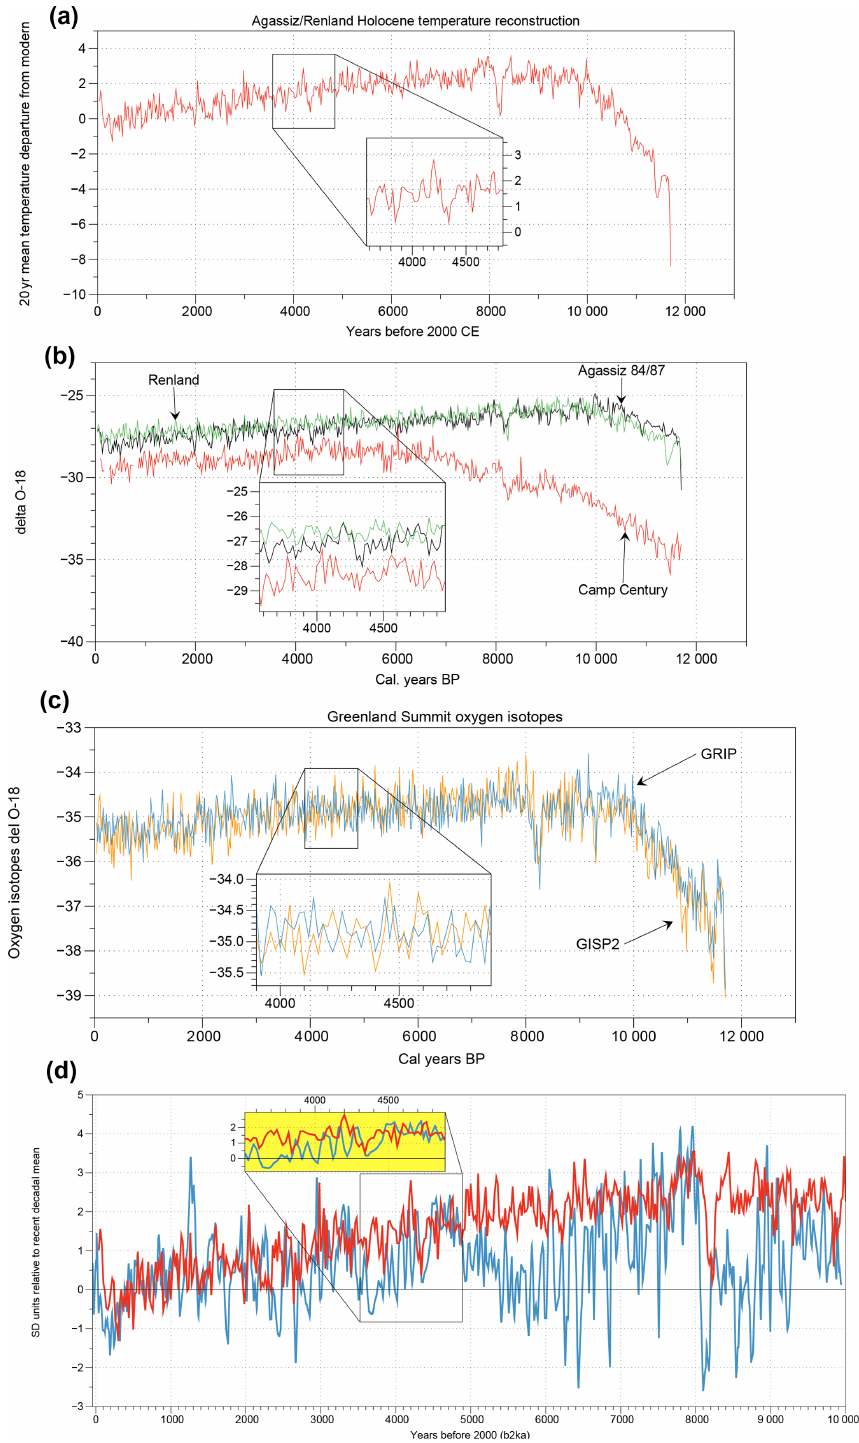
Figure 3. (a) Temperature anomalies from the smoothed estimate of present temperatures in Greenland based on oxygen isotope records from Renland Ice Cap (East Greenland) and Agassiz Ice Cap (Ellesmere Island). Timescale is in years b2k (before 2000CE). The interval around 4.2kaBP is enlarged in the box (data source: Vinther et al., 2009). For locations, see Fig. 5. (b) Individual oxygen isotopic records from Renland and Agassiz ice caps (which were combined to create the record in Fig. 3a) and from Camp Century. (c) Individual oxygen isotopic records from GRIP and GISP2 at Summit, Greenland Ice Sheet. (d) Paleotemperature estimates from argon and nitrogen isotopes (in blue) (from Kobashi et al., 2017) and from the Renland–Agassiz joint record (in red) as shown in Fig. 3a (from Vinther et al., 2009).